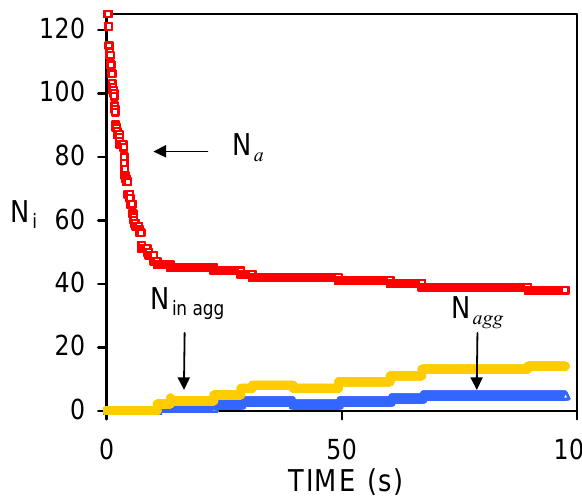
Figure 4. Behavior of system #13 from Refs. [19, 73-74]. The subscripts are the same of = 8.65 x 10 -5 M, A = 1.24 x 10 -19 J). Figure 3. ( φ = 0.22, C s H